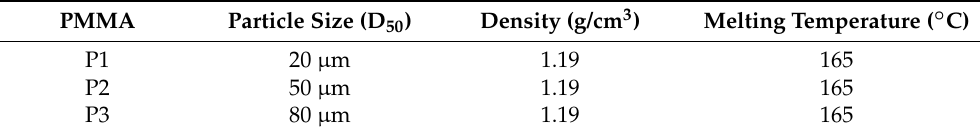
Table 3. Powder space holder (PMMA) characteristics used for feedstock.